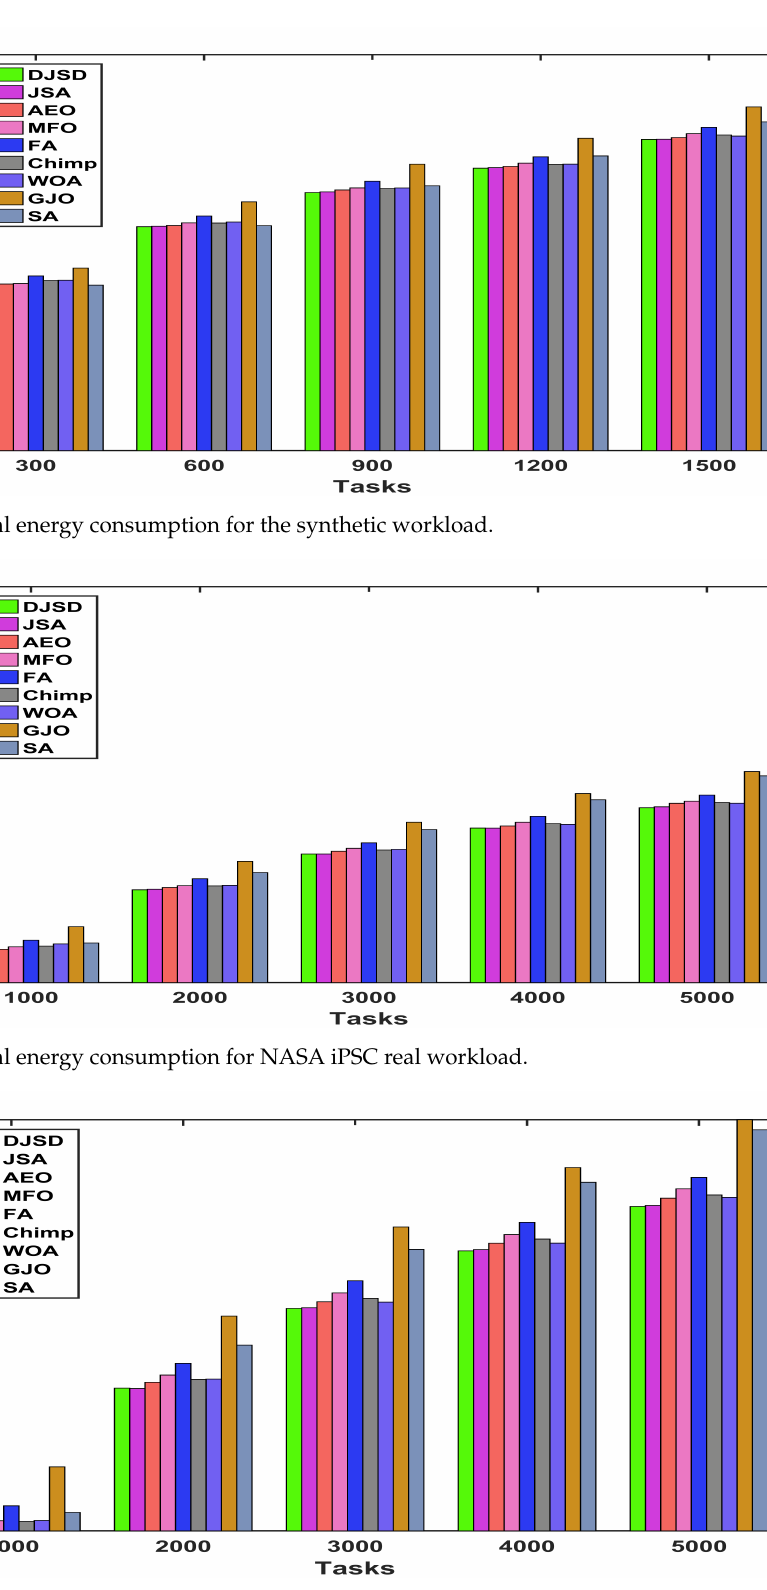
Figure 12. Total energy consumption for HPC2N real